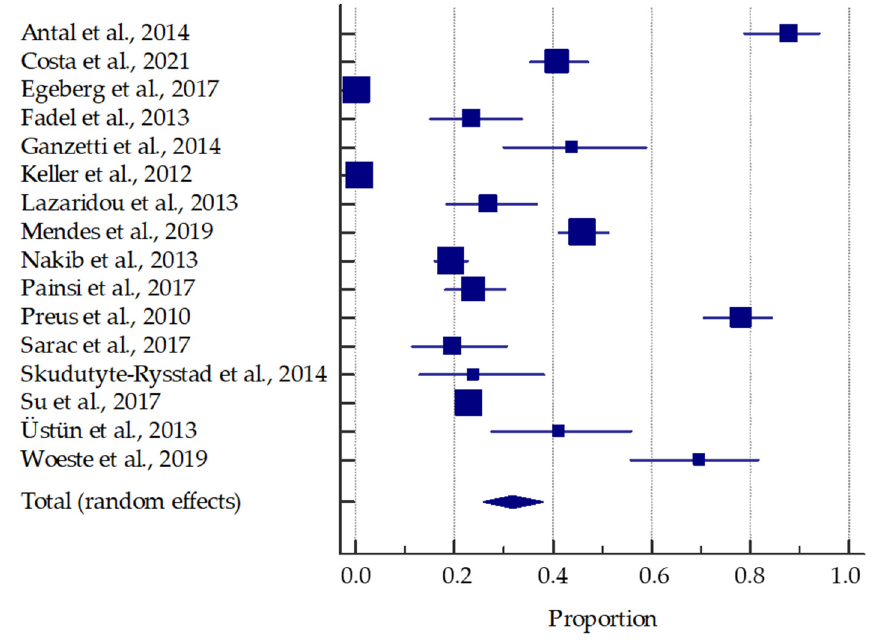
Figure 3. Forest plot presenting the pooled prevalence of periodontal disease in patients with psoriasis [33–35,40–52].